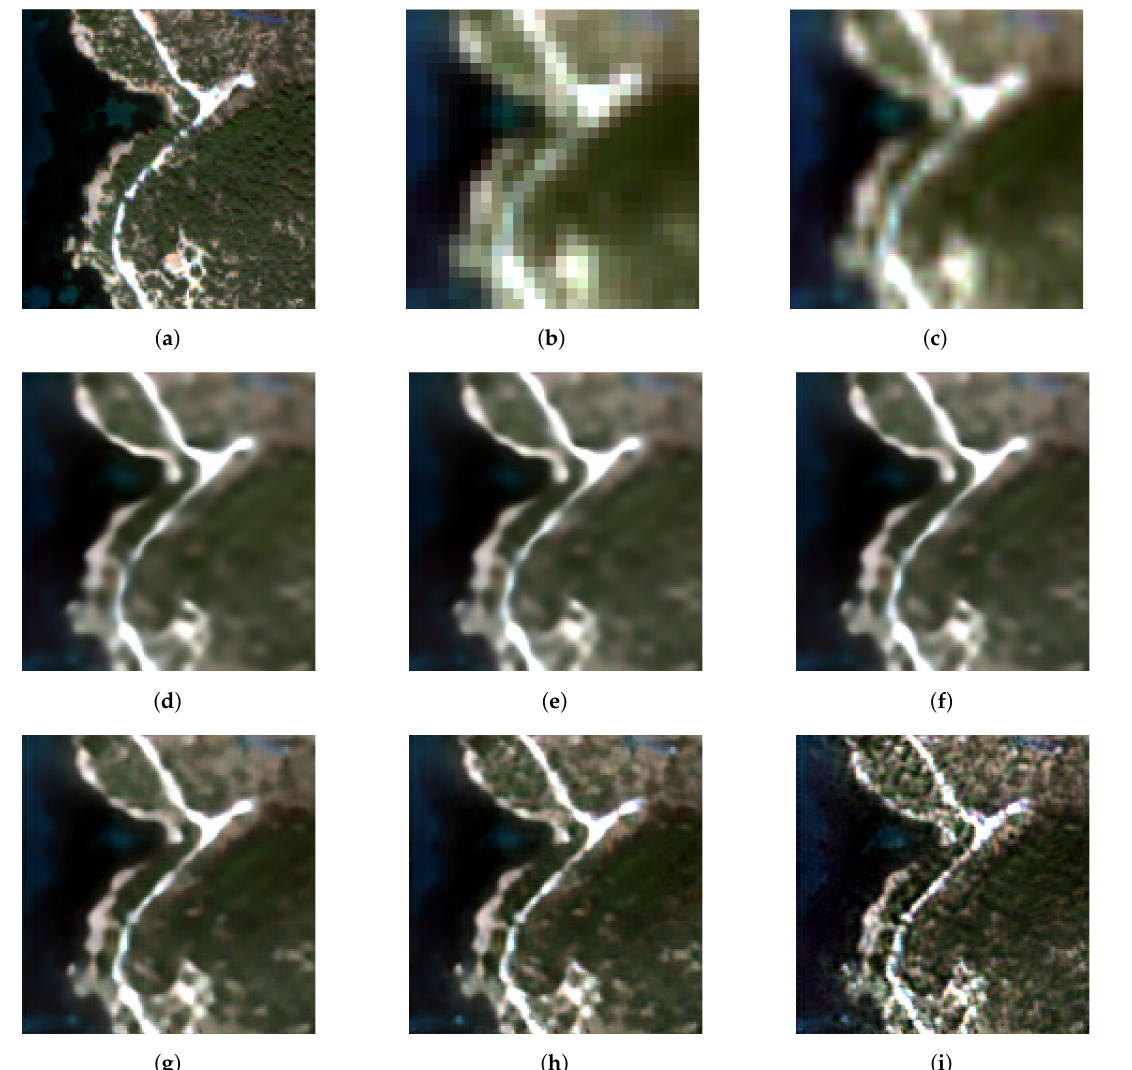
Figure 7. Results of a region of Cabrera from W-S Set1. ( a ) HR, ( b ) LR with NN interpolation, ( c ) LR with bicubic interpolation, ( d ) SR with α = 0, ( e ) SR with α = 0.1, ( f ) SR with α = 0.2, ( g ) SR with α = 0.5, ( h ) SR with α = 0.7, ( i ) SR with α = 1. Image size: 140 × 140 pixels.